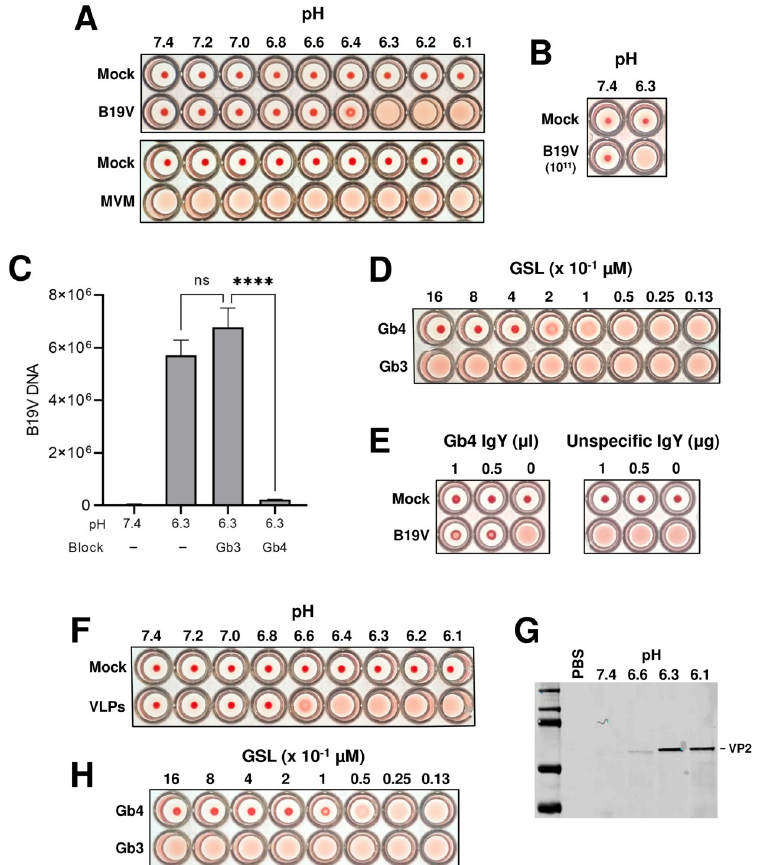
Fig 3. B19V interacts with soluble and membrane Gb4 in a pH-dependent manner. (A) Hemagglutination of human RBCs (0.5% in 100 μ l PiBS) by B19V or MVM (5x10 9 ) at different pH values. (B) Hemagglutination of RBCs with a 20-fold increase of B19V particles at pH 7.4 and 6.3. (C) Quantitative analysis of B19V binding to RBCs at pH 7.4 and 6.3 in the presence or absence of GSLs (Gb3 or Gb4). Virus (5x10 9 ) was incubated directly with RBCs (0.5% in 100 μ l PiBS) at the indicated pH or pre-blocked with 5x10 14 molecules (Gb3 or Gb4) for 1h at pH 6.3 prior to incubation with RBCs. After 1h at room temperature, the erythrocytes were washed four times with the corresponding buffer and the viral DNA was extracted and quantified. The results are presented as the mean ± SD of three independent experiments. ���� , p < 0.0001; ns, not significant. (D) Hemagglutination inhibition test in the presence or absence of different amount (0.013–1.6 μ M) of GSLs (Gb3 or Gb4) at pH 6.3. (E) Hemagglutination inhibition test in the presence of anti-Gb4 or non-specific IgY antibodies at pH 6.3 (antibodies were incubated with RBCs 1h before adding the virus). (F) Hemagglutination of RBCs (0.5% in 100 μ l PiBS) by VLPs (5x10 9 ) at different pH values. (G) Detection of VLPs bound to RBCs at different pH values by Western blot using antibody 3113-81C. (H) Hemagglutination inhibition test in the presence or absence of different amount (0.013–1.6 μ M) of Gb3 or Gb4 at pH 6.3. presence of soluble Gb3 did not prevent the interaction, a significant inhibition of the binding was observed in the presence of soluble Gb4 (Fig 3C). Confirming this observation, Gb4 ( > 0.2–0.4 μ M) but not Gb3 inhibited hemagglutination of RBCs in a dose-dependent manner (Fig 3D). Likewise, hemagglutination was inhibited in the presence of a specific antibody against Gb4 (Fig 3E). To verify that binding to Gb4 is exclusively due to a pH-mediated capsid rearrangement, the interaction was also tested with B19 virus-like particles (VLPs) consisting of VP2 (VP2-only particles). Recombinant baculoviruses that express VP2-only VLPs were prepared using the Bac-to-Bac system. The purity of the VP2 particles was verified by SDS-PAGE and